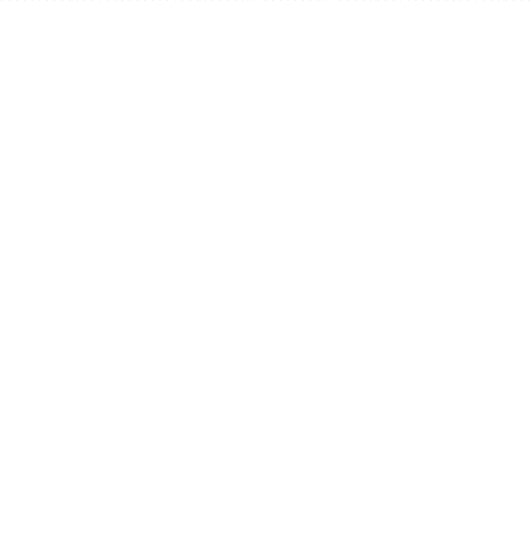
Figure 2. The differences in the area of CSF in ( a ) the kaggle dataset the images from left to write as no dementia, very mild dementia, mild dementia and moderate dementia ( b ) the ADNI datasets the images from left to right as CN, MCI and AD.